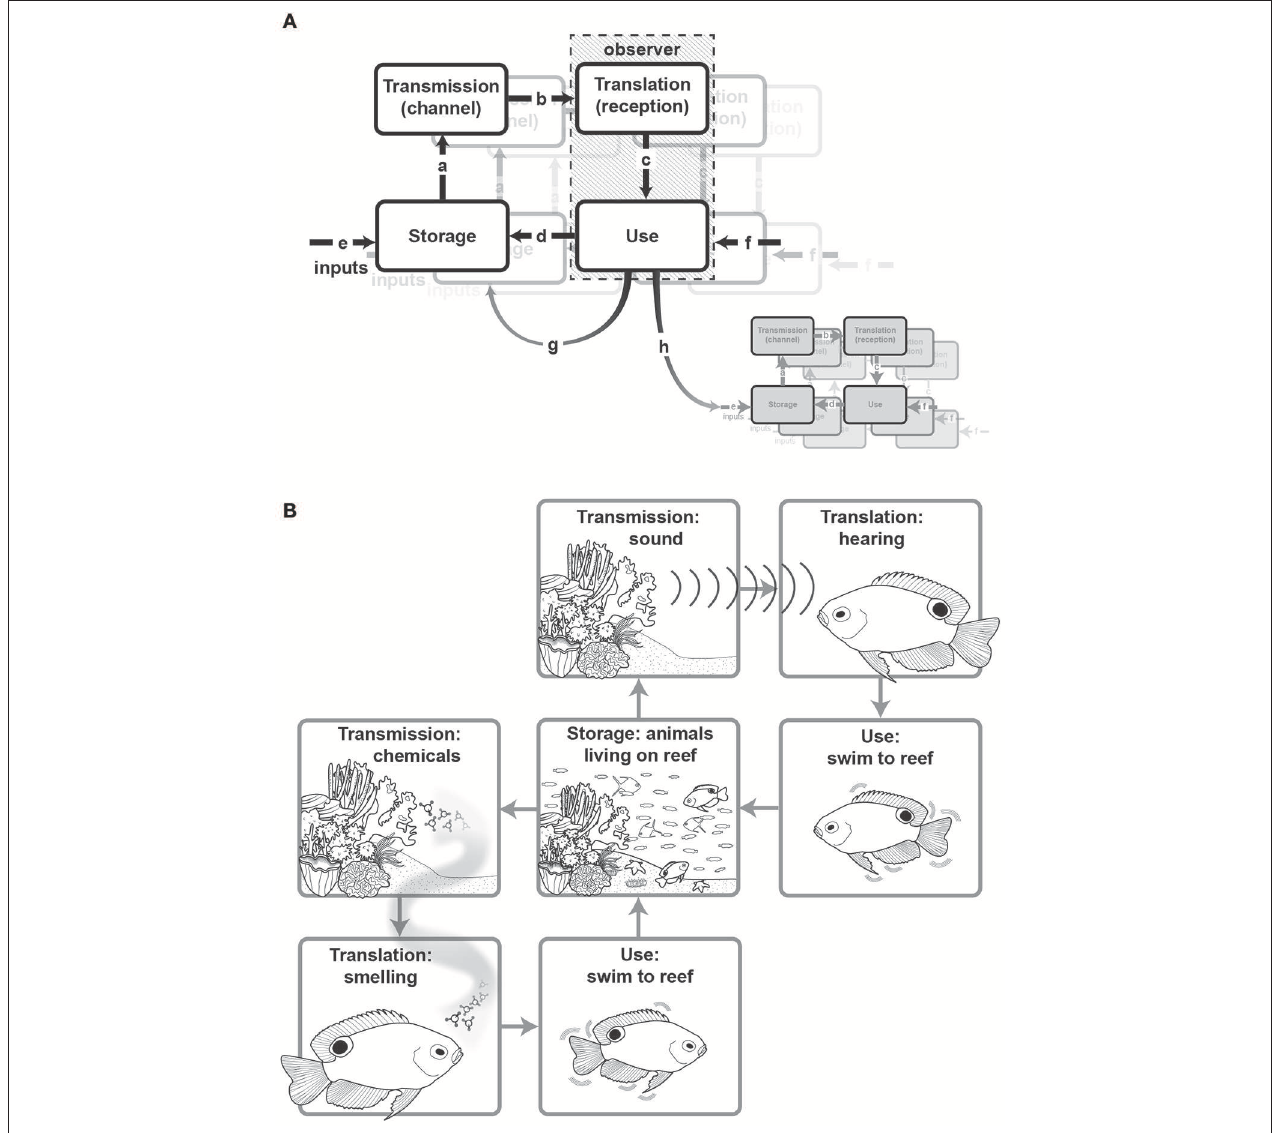
FIGURE 2 | Four steps of information processing. (A) Information processing can occur within a closed feedback loop (a - > b - > c- > d), or by accepting information from outside the loop (e - > a- > b - > c…) and can lead to information that is used by the processing systems outside the focal system (e.g., c - > h or c- > g). Information processing requires an observer, which often constitutes the reception and use of information. Inputs to any processing system may be information instantiated in chemical, electrical, energetic, or material structures. (B) Coral reef fish use olfactory ( Osterhinchus doederleini ) (Gerlach et al., 2007) and auditory (Gordon et al., 2018) information to relocate their home reef. The information stored in the sound or chemical patterns in the water are received by fish sensory systems—themselves information systems—and used to guide behavioral responses such as swimming to the reef and remaining there, and the recruitment of fish to these reefs contributes to structure at population and community